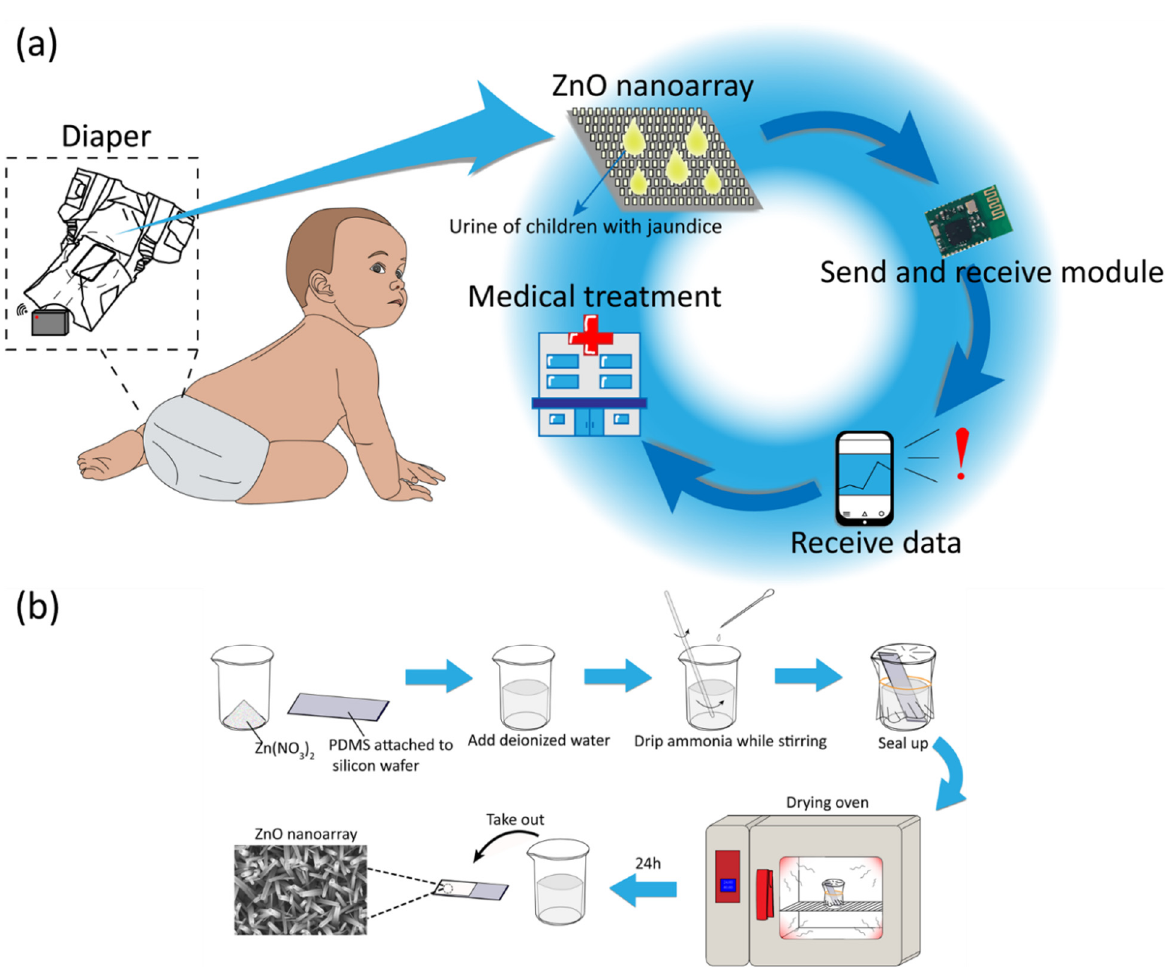
Figure 1. ( a ) The experimental design of self-powered wearable biosensor in baby diaper for moni- toring neonatal jaundice. ( b ) Manufacturing process of ZnO nanoarray on PDMS film.